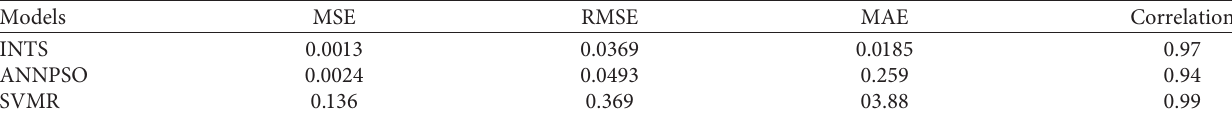
Figure 5: ANNPSO model used to predict the influenza epidemic. Table 3: Results of prediction models for predicting influenza epidemics using Google search queries.